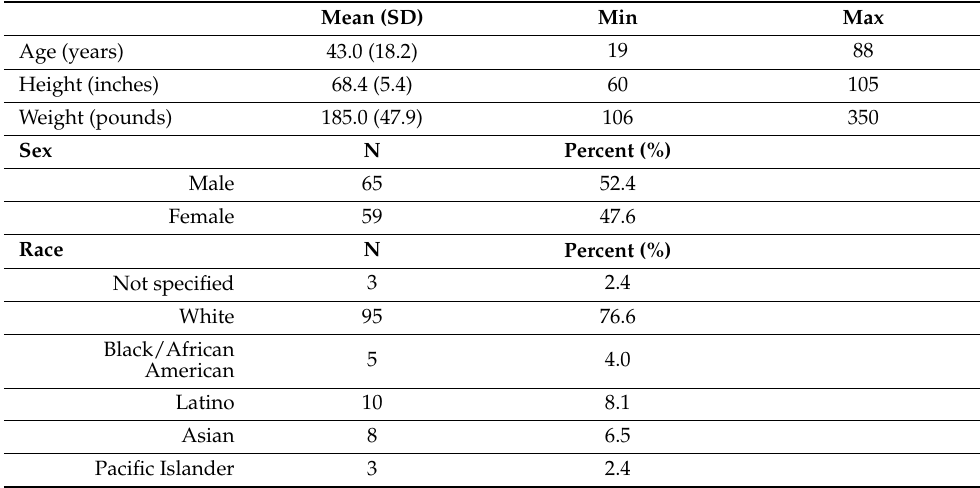
Table 1. Descriptive characteristics of the sample (N =